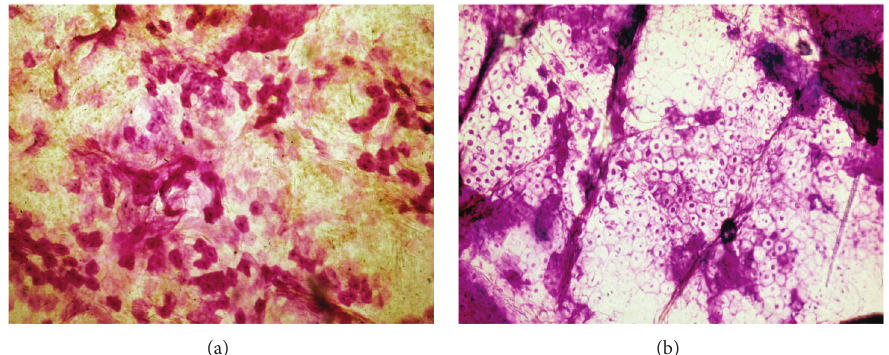
Figure 4: Parakeratotic cells. (a) Dispersed pattern. (b) Cohesive pattern in seborrheic